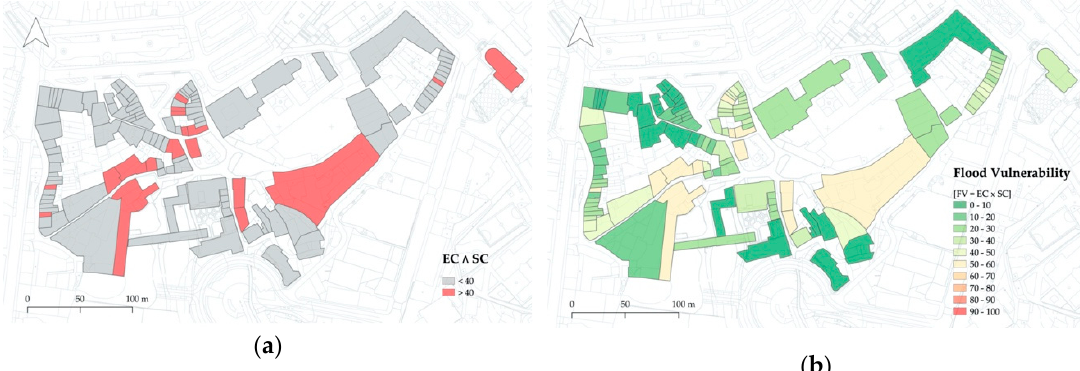
Figure 9. Cross analysis of the exposure and the sensitivity indicators ( a ) and spatial distribution of the vulnerability index results ( b ).